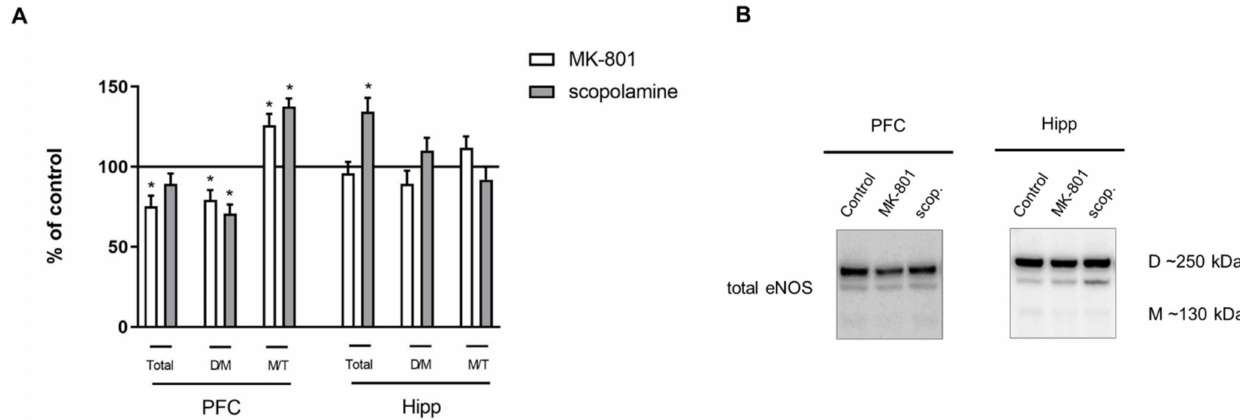
Figure 12. eNOS expression in the prefrontal cortex (PFC) and hippocampus (Hipp) after chronic (14 days) administration of MK-801 (0.3 mg/kg) or scopolamine (1 mg/kg) ( A ). Representative Western blots ( B ). D/M—dimer/monomer ratio; M/T—monomer/total ratio. Data are presented as means ± SEM. * p < 0.01 vs. control.